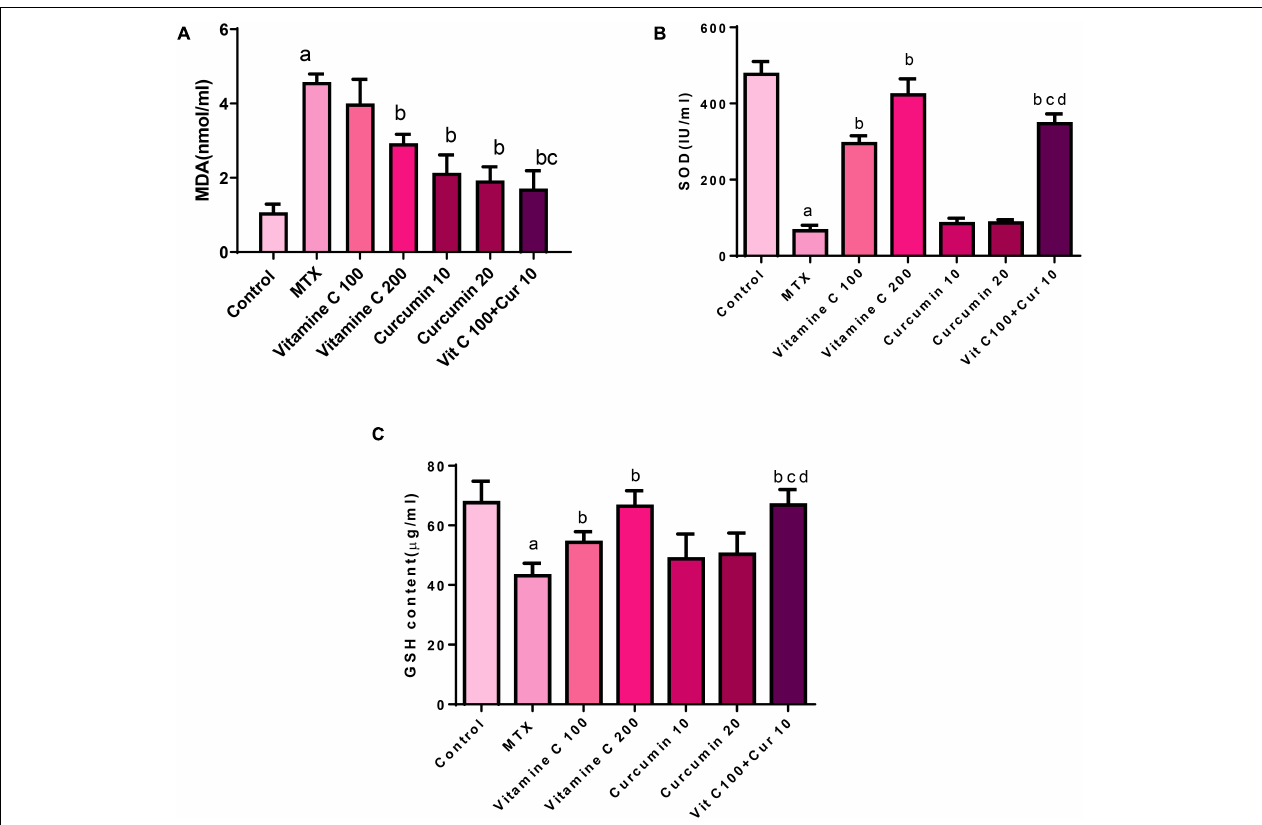
FIGURE 2 | Effects of vitamin C and curcumin pretreatment alone and in combination on (A) MDA tissue level, (B) SOD activity, and (C) GSH tissue level (a) MTX compared to the control P < 0.05, (b) vitamin C or curcumin compared to MTX P < 0.05, (b,c) combination VC and CUR compared to VC or CUR alone P < 0.05, (b–d) combination VC and CUR compared to VC or CUR alone P <